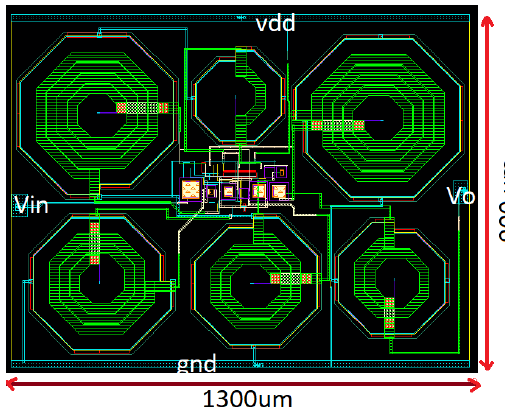
Figure 16. Noise floor (NF) simulation result.